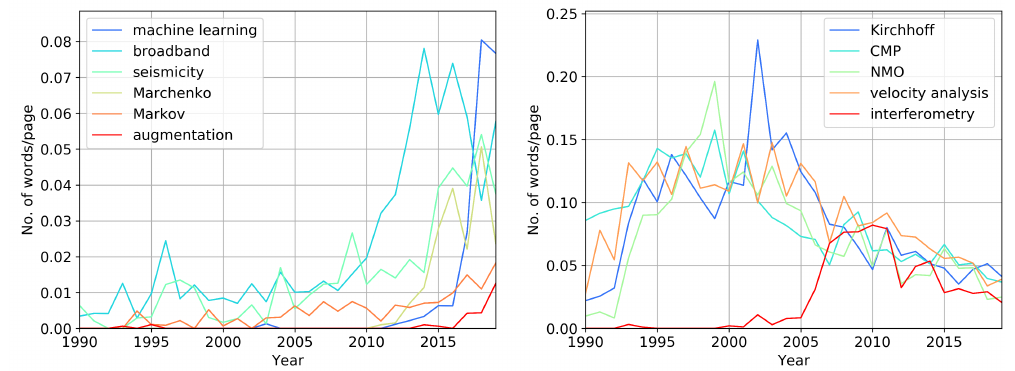
Figure 7. Trends in seismic data processing, terms, and algorithms that start to grow in usage ( left ) and decline in occurrence ( right